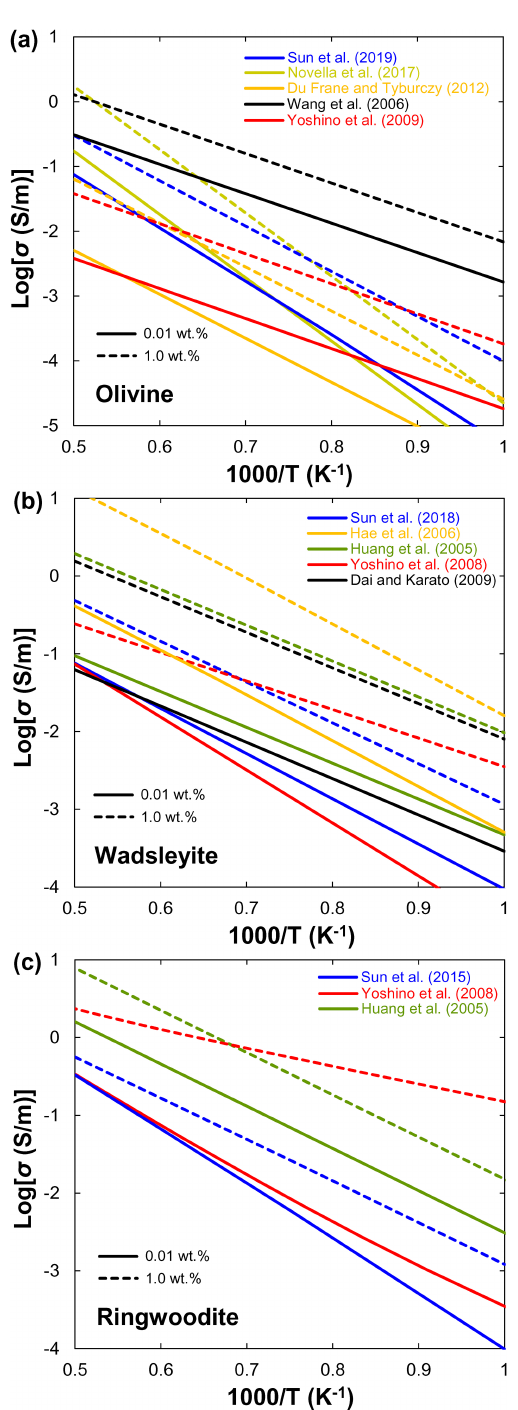
Figure 15. Comparison of laboratory conductivity data with the calculated conductivity from hydrogen diffusion results through Eq. (12) as a function of 1 /T for different water contents in (a) olivine, (b) wadsleyite, and (c) ringwoodite.